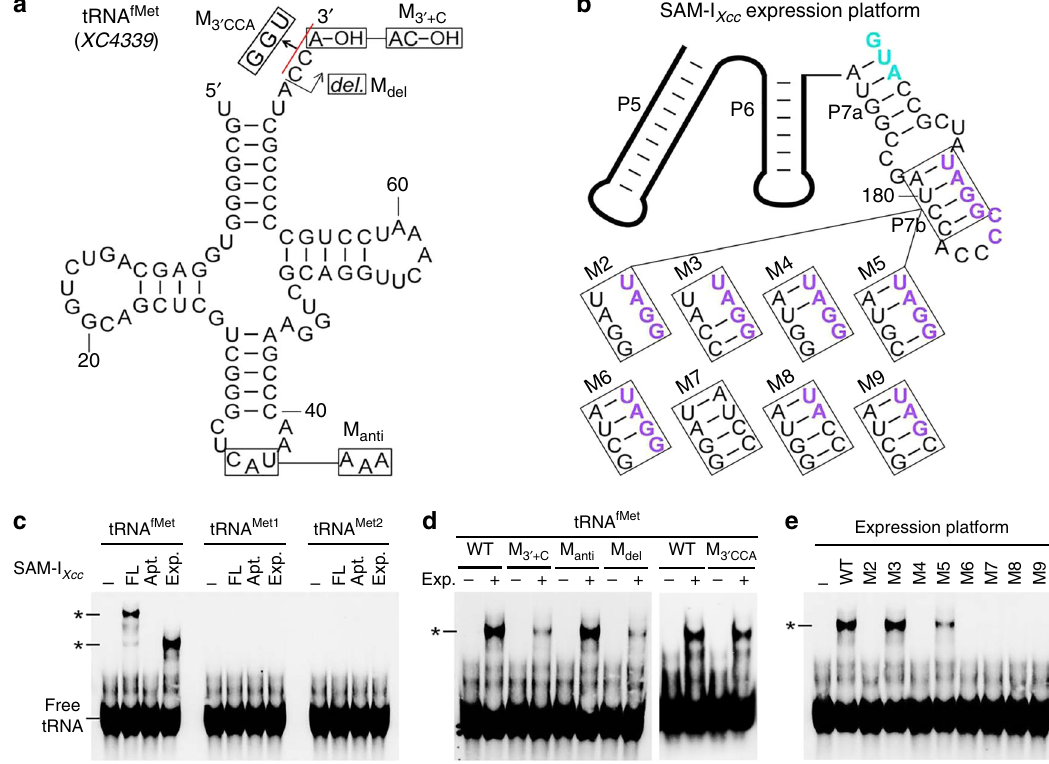
Fig. 4 The SAM-I Xcc expression platform binds with initiator Met-tRNA (tRNA fMet ). a Sequence and secondary structure of Xcc tRNA fMet . Mutant constructs include the charged tRNA fMet mimic (M 3 ′ + C ), the CAU to AAA mutation in anti-codon (M anti ), and the deletion of the 3 ′ CCA (M del ) and the substitution of 3 ′ CCA with GGU (M 3 ′ CCA ). b Mutant constructs (M2 to M9) examined in SAM-I Xcc expression platform for the interaction between tRNA fMet and SAM-I Xcc . c EMSA detection of the speci fi c binding of tRNA fMet to SAM-I Xcc expression platform. The full-length (FL), the aptamer (Apt.), and the expression platform (Exp.) of SAM-I Xcc were examined individually with the uncharged and DIG-labeled Met-tRNAs in Xcc , including tRNA fMet , tRNA Met1 , and tRNA Met2 (elongator tRNAs). Bands referring to the complex of tRNA and SAM-I Xcc or the expression platform of SAM-I Xcc (*) are pointed out. d , e EMSA assay revealing the potential binding site in tRNA fMet and SAM-I Xcc expression platform. Mutant constructs tested are depicted in a and b . For the assay, same conventions apply as in c . Source data are provided as a Source Data fi